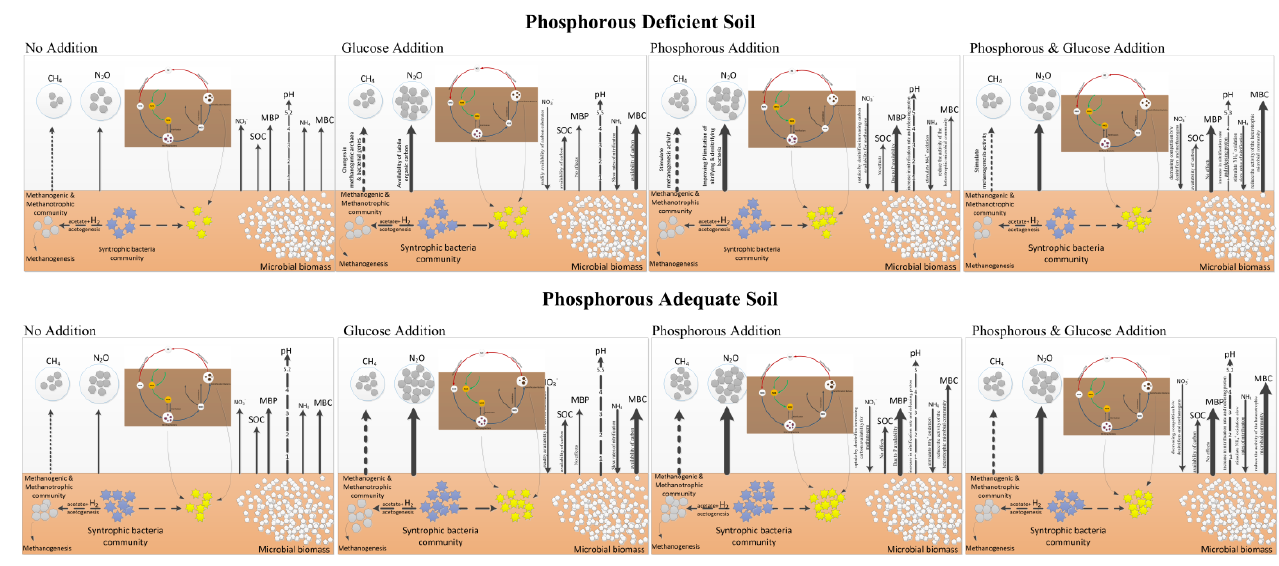
Figure 6. Conceptual diagram of practical and hypothetical effects of applied treatment in current study.